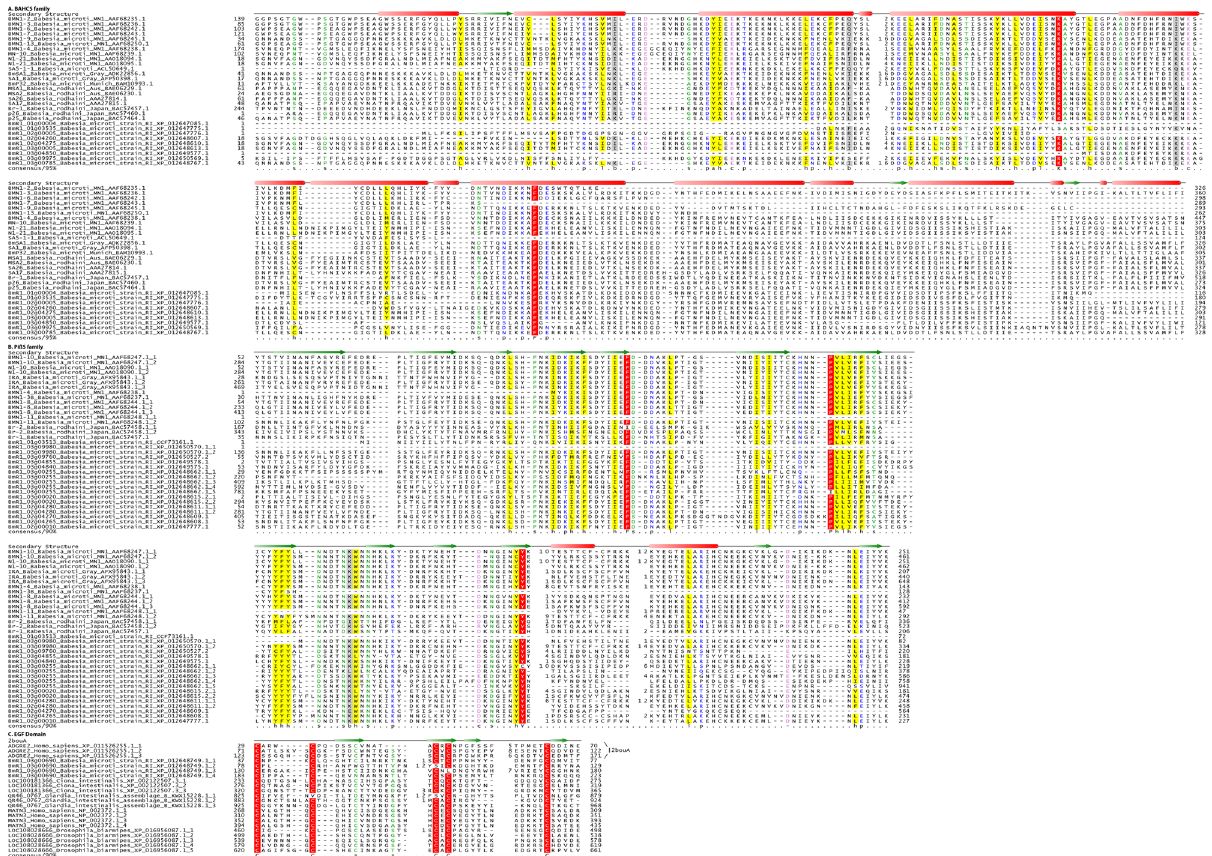
Figure 3. Multiple Alignment of (A) BAHCS family (B) Pi β S family (C) EGF domain containing BmR1_03g00690 family. Representative multiple sequence alignments of the families are shown with a 95%, 90% and 90% consensus, respectively. The sequences are denoted by their gene names or gene IDs, species names, and accession numbers. Proteins with repeats are shown with underscore followed by the repeat number. The amino acid range is shown at the beginning and end of the sequence. The numbers within the alignment represent poorly conserved inserts of the given number of amino acid residues that are not shown. The predicted secondary structure or the crystal structure are shown with orange cylinders representing helices and green arrows representing beta sheets. The coloring is based on the consensus of the whole family alignment: “h” is for hydrophobic residues (ACFILMVWY [yellow]); “l” represents the aliphatic subset of the hydrophobic class [ILV (yellow]); “s” represents small residues (ACDGNPSTV (green)); “u” represents the tiny subclass of small residues (GAS [green]); “p” represents polar residues (CDEHKNQRST [blue]); “c” represents the charged subclass of polar residues (DEHKR [pink]); “—“ represents the negative subclass of charged residues (DE); “o” represents alcoholic residues (ST[orange]); and “b” represents big residues (KFILMQRWYE [gray]). Any absolutely conserved residue is labeled and shaded